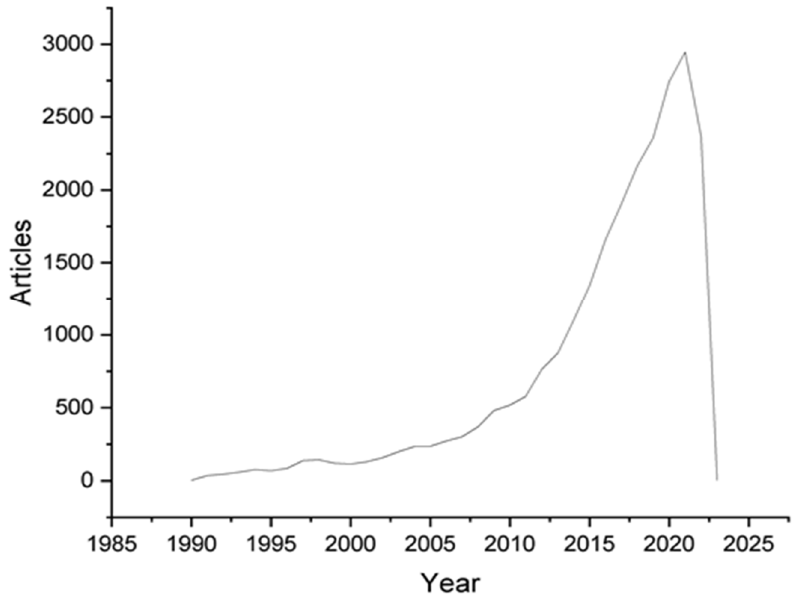
Figure 3. Publications growth trend research from 2005 to 2022.